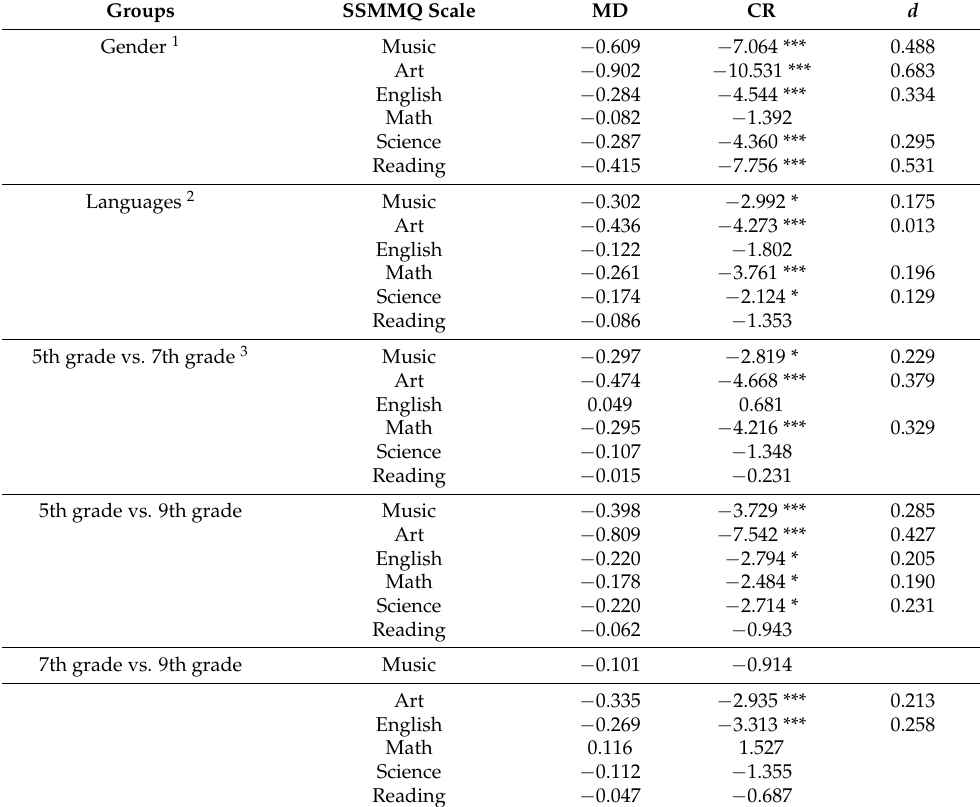
Table 9. Latent mean differences for language, gender, and